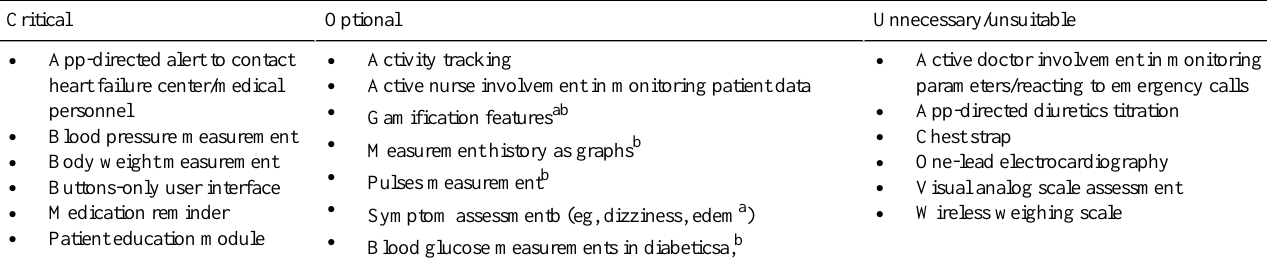
Table 2. App features evaluated by a panel of 8 cardiologists and 2 physicians with mHealth expertise.